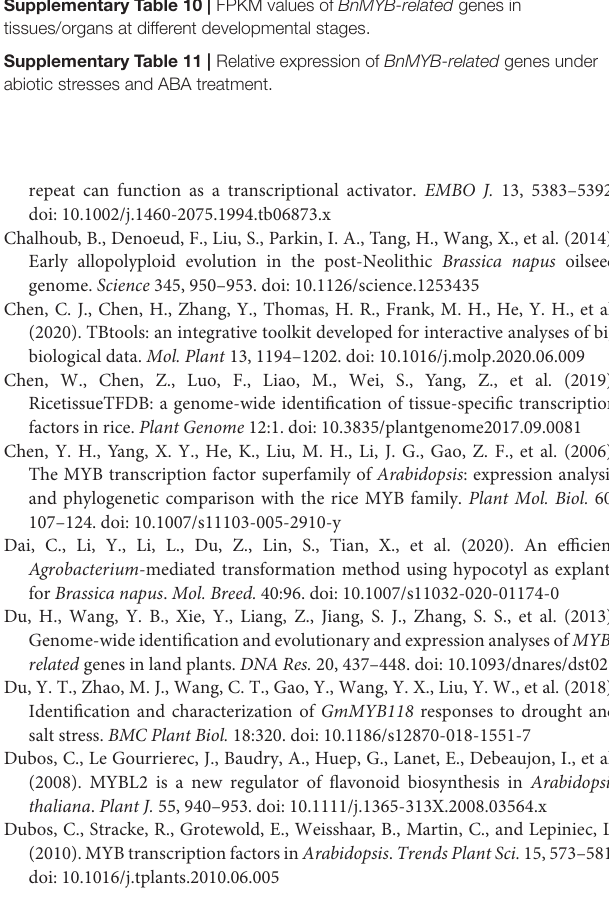
Supplementary Table 1 | List of the primers used in this study. Supplementary Table 2 | General information of BnMYB-related genes. Supplementary Table 3 | Ka/Ks ratios of the duplicated BnMYB-related genes pairs. Supplementary Table 4 | Duplication type of BnMYB-related genes. Supplementary Table 5 | Ka / Ks ratios of the duplicated MYB-related gene pairs of B. napus and Arabidopsis . Supplementary Table 6 | Ka / Ks calculation of the duplicated BnMYB-related gene pairs of B. napus and B. oleracea . Supplementary Table 7 | Ka / Ks ratios of the duplicated BnMYB-related gene pairs of B. napus and B. rapa . Supplementary Table 8 | Homologous members of MYB-related genes in eight rapeseed accessions. Supplementary Table 9 | Cis -elements in the promoter regions of BnMYB-related